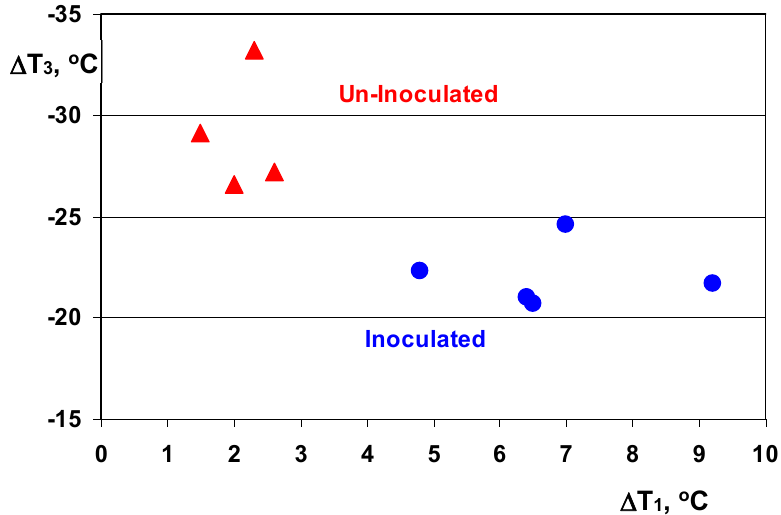
Figure6. Undercoolingreferringtothemetastableeutectictemperature( T mst)attheendofsolidification ( ∆ T 3 ) and at the lowest eutectic temperature ( ∆ T 1 ) Figure 6. Undercooling referring to the metastable eutectic temperature (Tmst) at the end of solidification (ΔT 3 ) and at the lowest eutectic temperature (ΔT 1 ) relationship.